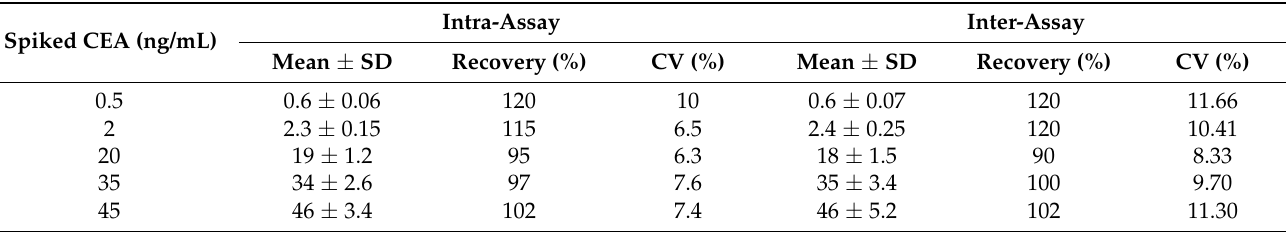
Table 1. The obtained recovery and coefficient of variation (CV) results for CEA-spiked serum samples using the developed